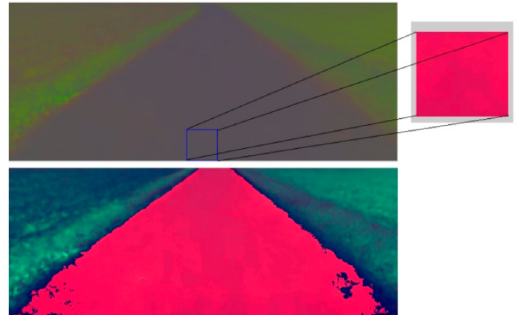
Figure 4. Road window located in the middle bottom of size 50 × 50 pixels.